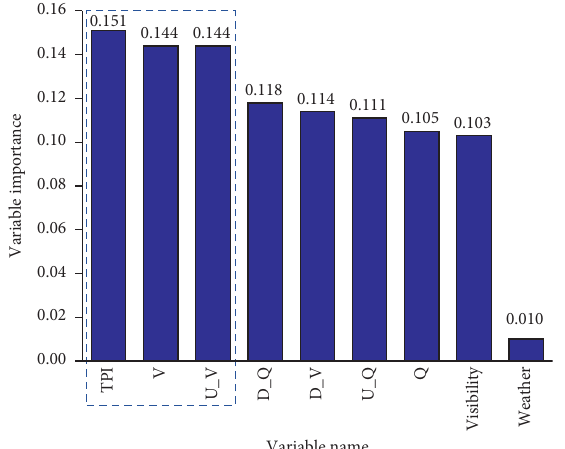
Figure 2: Variable importance ranking determined by Random Forest.